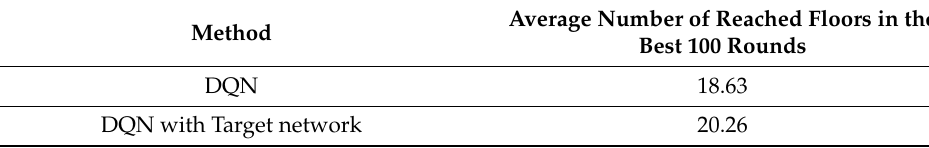
Figure 7. Comparison of the number of floors between DQN and DQN with Target network. Table 6. Average number of reached floors in the best 100